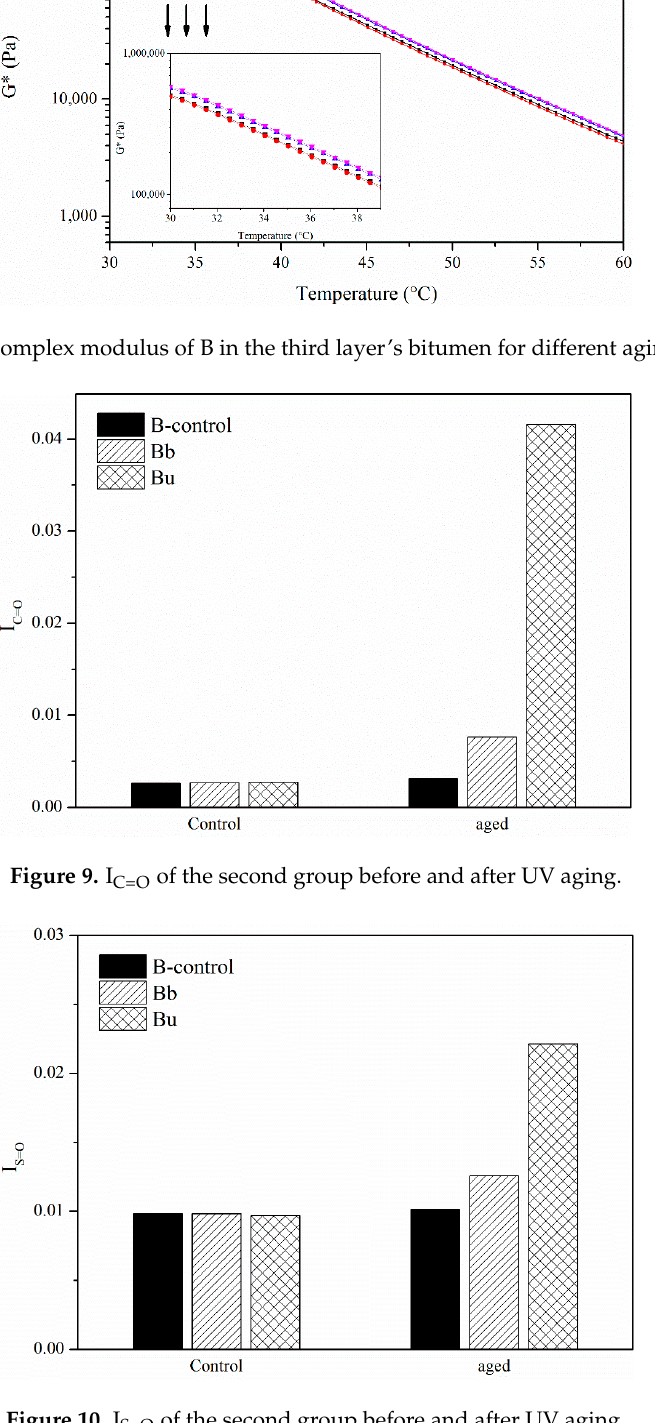
Figure 8. Complex modulus of B in the third layer’s bitumen for different aging times.